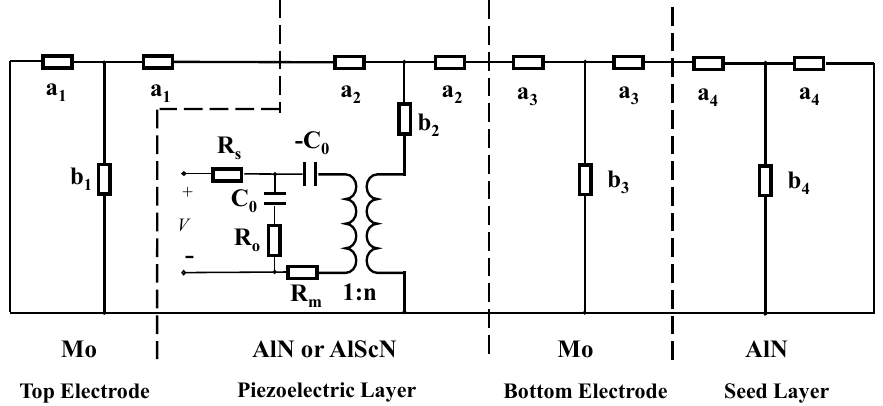
Figure 4. Electromechanical equivalent Mason model of FBARs.